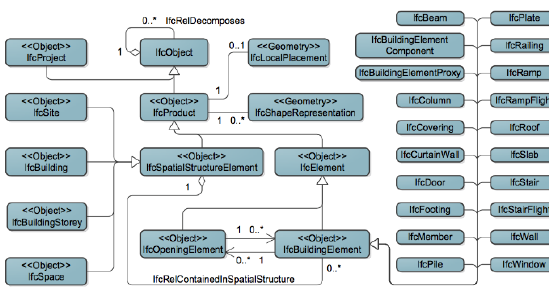
Figure 1: UML Diagram of the most relevant IFC Entities for CityGML (Nagel & Kolbe, 2007)